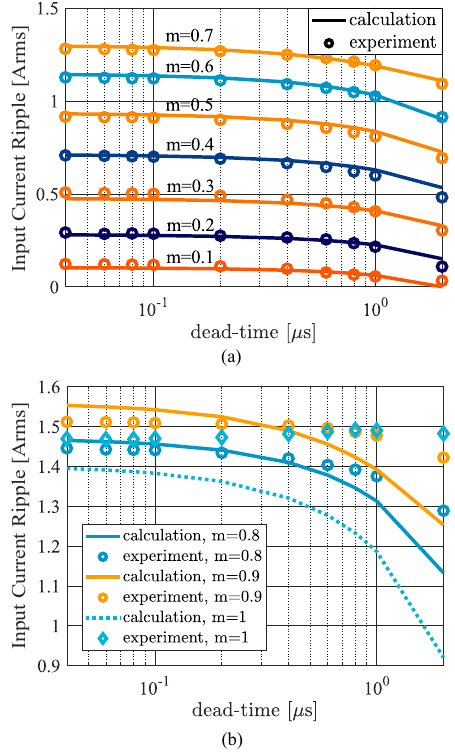
Figure 15. Calculation and experimental results of dead-time vs. rms input current ripple of the three-phase VSI (case 1 load) for ( a ) 0.1 ≤ m ≤ 0.7; ( b ) 0.8 ≤ m ≤